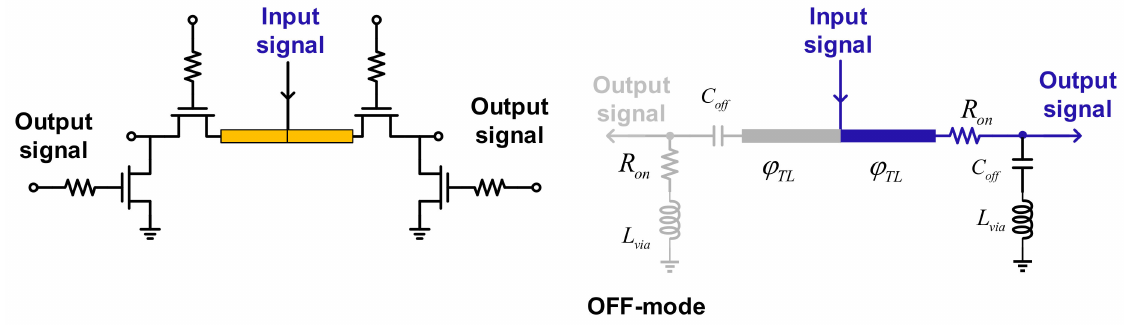
Figure 6. The switch with transmission line connection and different mode